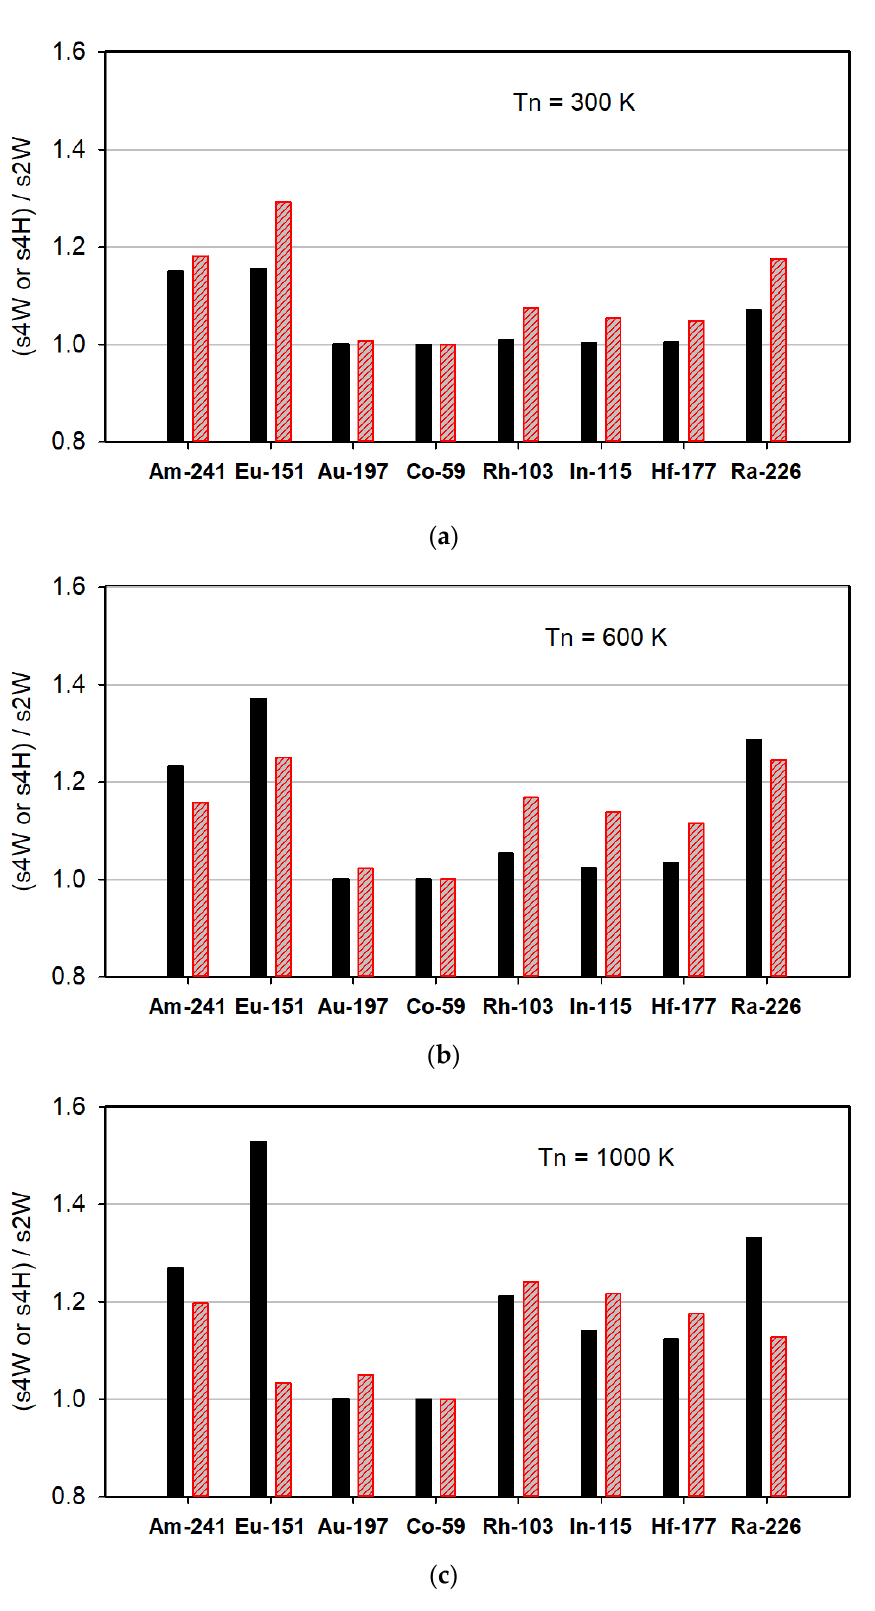
Figure 14. ( a ) Ratios of s-factors, s 4𝑊 /s 2𝑊 (black bar), and s 4𝐻 /s 2𝑊 (red dashed bar) for 241 Am, 151 Eu, 197 Au, 59 Co, 103 Rh, 115 In, 177 Hf, and 226 Ra at the neutron temperature of 300 K; ( b ) Same as ( a ) at the neutron temperature of 600 K; ( c ) Same as (a) at the neutron temperature of 1000 K.